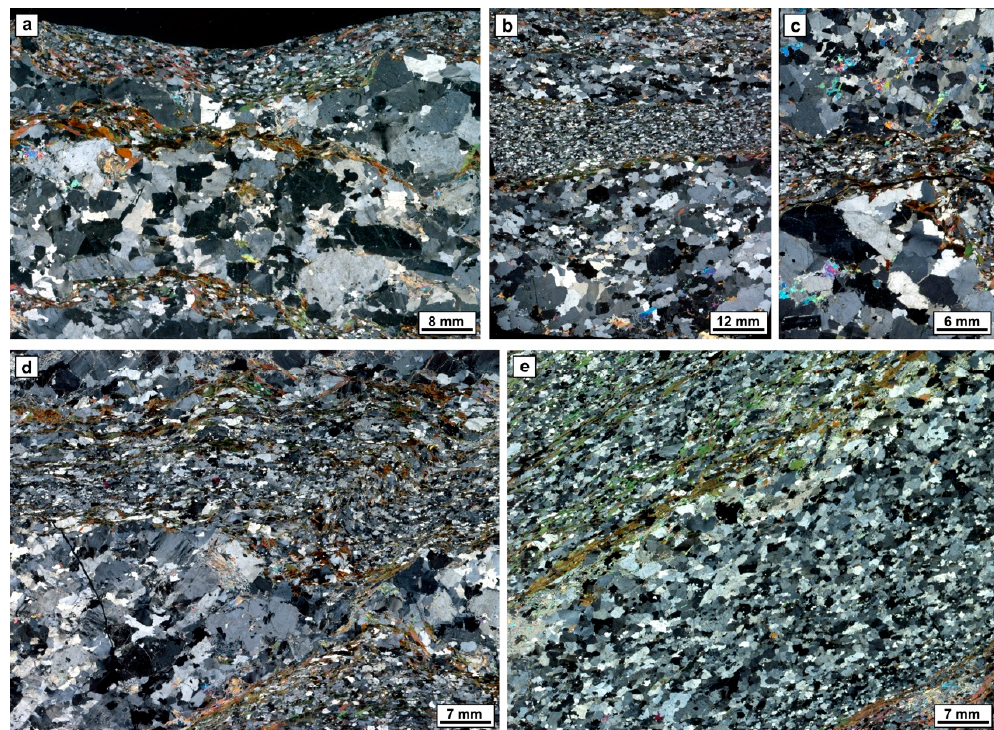
Figure 2. Representative thin-section scans of migmatite samples from Pizzo Bottino (crossed polars). ( a ) sample PB14a, characterized by a Bt-rich melanosome of restitic appearance in the upper part of the image, with sillimanite at its right termination. Bt-Sill(Ms) rounded nodules occur in the leucosome, in proximity of the melanosome. Leucosome grain size is significantly larger than in the mesosomes; ( b ) sample PB16, showing a fine-grained mesosome in the centre of the image, bordered on both sides by thin melanosomes of different thickness. The grain size of the thicker leucosome is visibly larger of the thinner leucosome in the upper part of the image; the latter leucosome also shows a more anisotropic fabric; ( c ) sample PB17, illustrating the distribution of muscovite in the leucosomes, while in the meso-melasonosomes this phase only occurs in rare mm-sized (relic) plats. This sample differs from the others in the absence of K-feldspar and sillimanite; ( d ) sample PB10, with folded meso-melanosomes. Ms-Sill aggregates occur in the leucosome, especially close to the melanosome, and are typically associated with Kfs-bearing domains (see Figure 3f for a zoom of the Ms–Sill aggregate from the center of the image); ( e ) sample PB12a, characterized by an abundance of garnet and granitic domains.